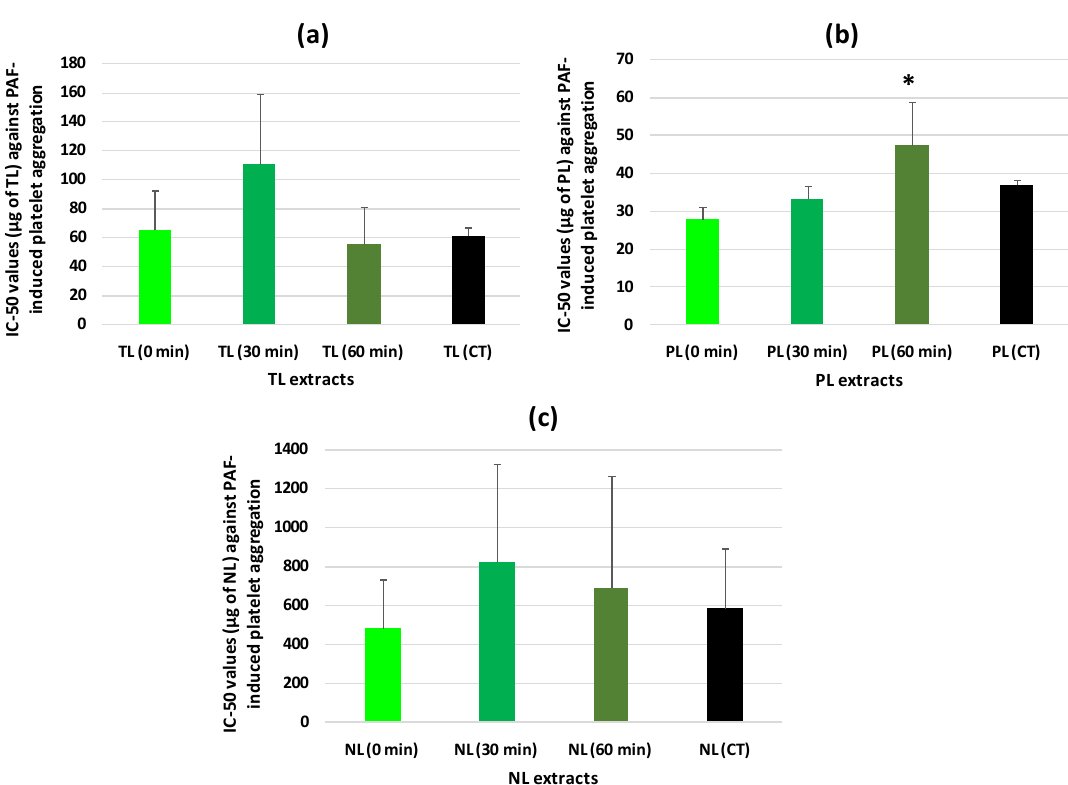
Figure 1. The antithrombotic effects of TL ( a ), PL ( b ), and NL ( c ) extracts from tea leaf samples, before (0 min) and after 30 and 60 min of oxidation, against PAF-induced aggregation of human platelets, in comparison to those of CT. Results are expressed as IC 50 (half-maximal inhibitory concentration) values that reflect the inhibitory strength of each TL, PL, and NL extract against PAF-induced platelet aggregation and is expressed as mean values of µ g of lipids in the aggregometer cuvette that causes 50% of inhibition on PAF-induced aggregation of platelets in hPRP ± SD. * Indicates statistical significant differences ( p < 0.05). TL: Total lipids; PL: Polar lipids; NL: Neutral lipids; CT: Commercial tea samples; PAF: Platelet-activating factor; hPRP: Human platelet-rich plasma; SD: Standard